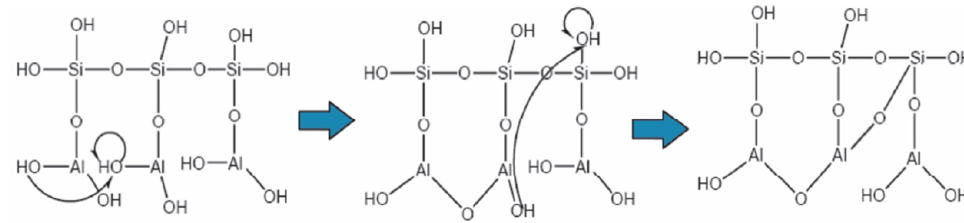
Figure 7. High-reactivity clays to form calcined clay. Reprinted with permission from Ref. [4]. Copyright: 2013, Mathieu Antoni. Published by Swiss Federal Institute of Technology Lausanne.